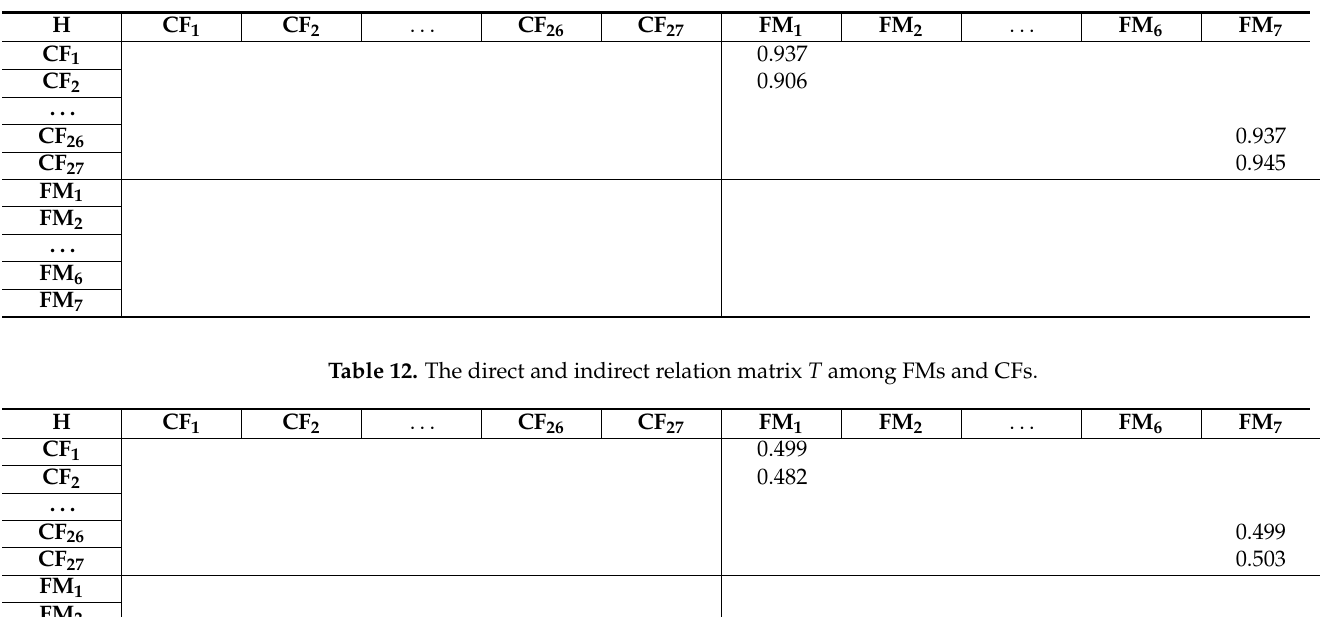
Table 11. The initial relation matrix Y .